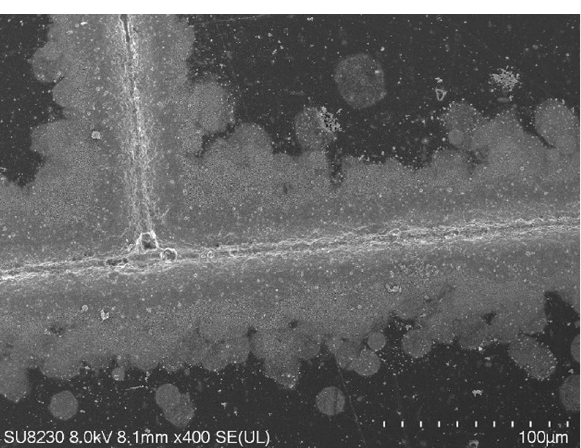
Figure 6. Overspray, characteristic Aerosol Jet Printing patterns element, emanating from the ink stream and expended by Saffman force 36 , visible for sample S2, in Scanning Electron Microscopy image (Auriga